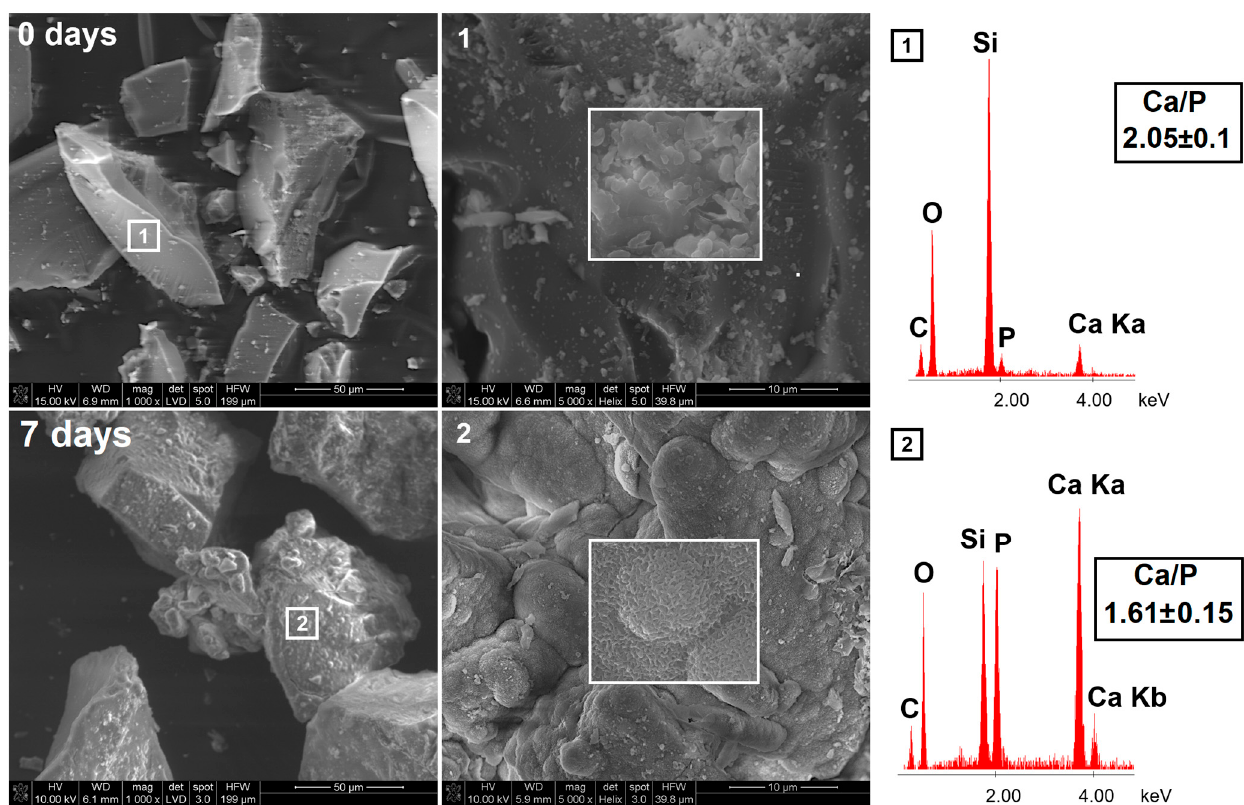
Figure 5. The SEM-EDX micrographs of synthesized bioglass before (upper row) and after (lower row) 7 days of incubation in SBF.